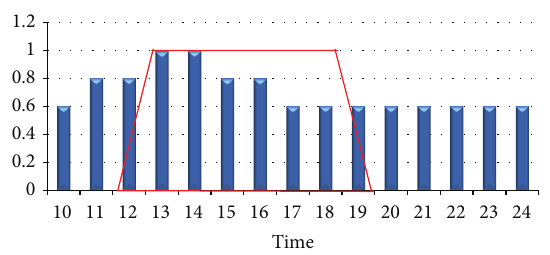
(ii) One can work on changing provided algorithm to flowcharts and create software. (iii) It is possible to use fuzzy numbers in estimating occurrence probability of activities and loops instead of probabilistic